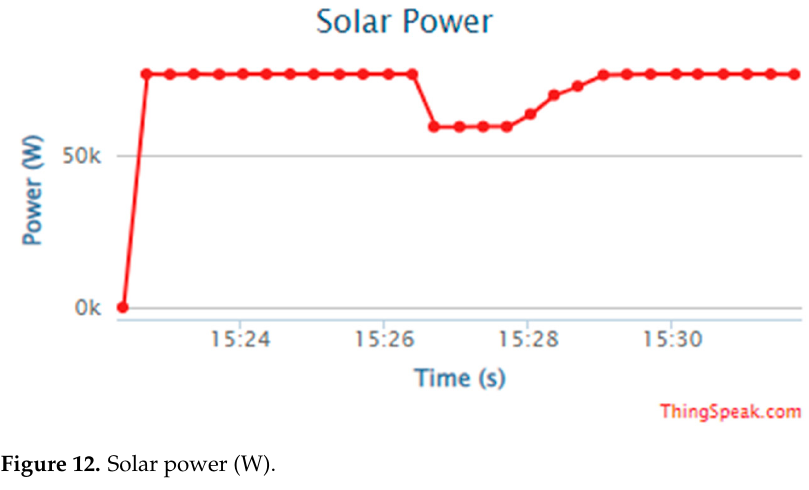
Figure 11. Proposed wind speed profile.